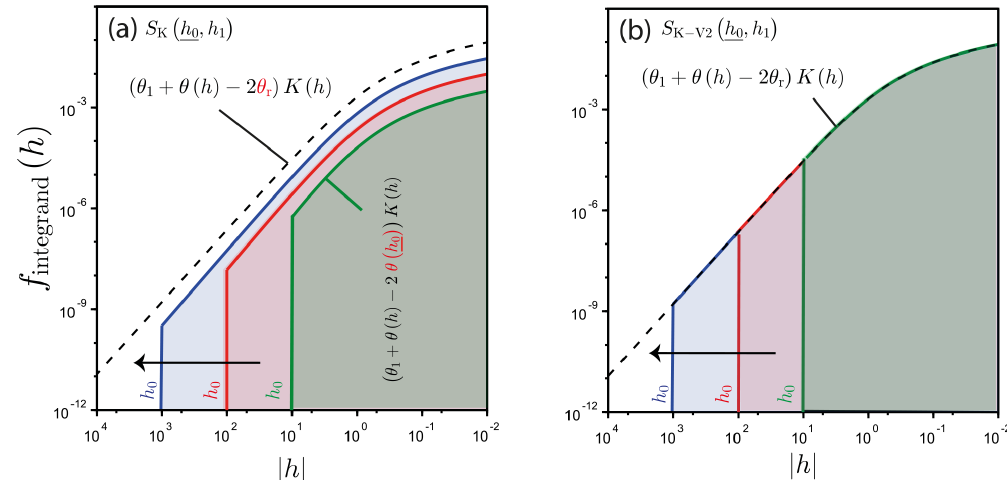
Figure 2. Illustration of the regular strategies for the estimation of the limits for the case of very dry conditions with the estimation of S( −∞ ,h 1 ) using either S K (h 0 ,h 1 ) , Eq. (5), (a) or S K-V2 (h 0 ,h 1 ) , Eq. (16), (b) . The integration proceeds from the given value of h 0 to the right, h ≥ h 0 , corresponding to the solid zones, and the value of h 0 is lowered step by step to reach the limit S( −∞ ,h 1 ) (see the arrow and the extension of the solid zones). In the equations, the variables that are adjusted to reach the targeted limits are underlined, and figures are zoomed in on in the vicinity of the limits. The differences in equations between the target and the integrated integrands are in red. An illustrative case of the computation of the limits of S K (h 0 ,h 1 ) or S K-V2 (h 0 ,h 1 ) for a synthetic loamy soil with a final water pressure head of h 1 = − 1mm; successive values are considered for the initial water pressure heads, h 0 ∈ {− 10 1 , − 10 2 , − 10 3 }